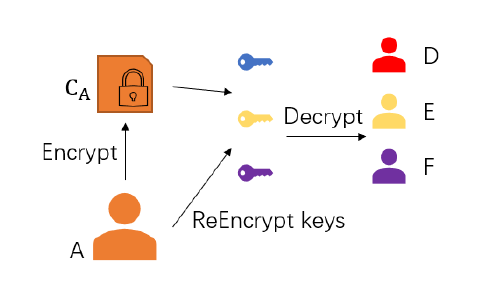
Figure 3. Our PRE scheme use C A and ReEncrypt key to